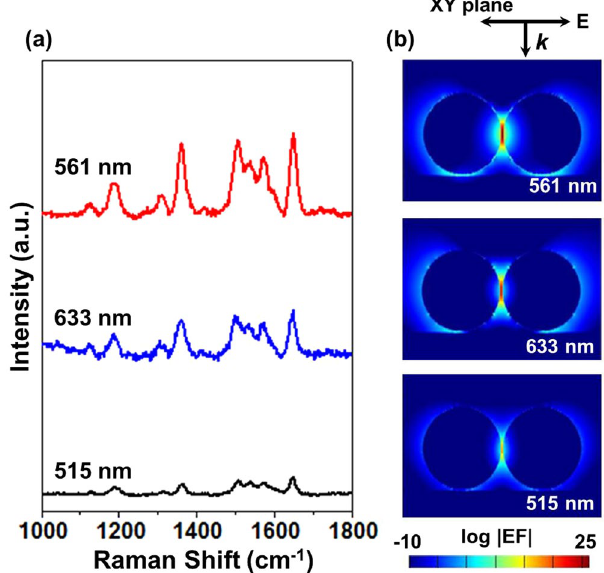
Figure 6. ( a ) SERS spectra of R6G at the excitation wavelengths of 515, 561 and 633 nm at the same power. ( b ) The FDTD calculated local electric field enhancement (log |EF|) of dimer AuNPs at the XY